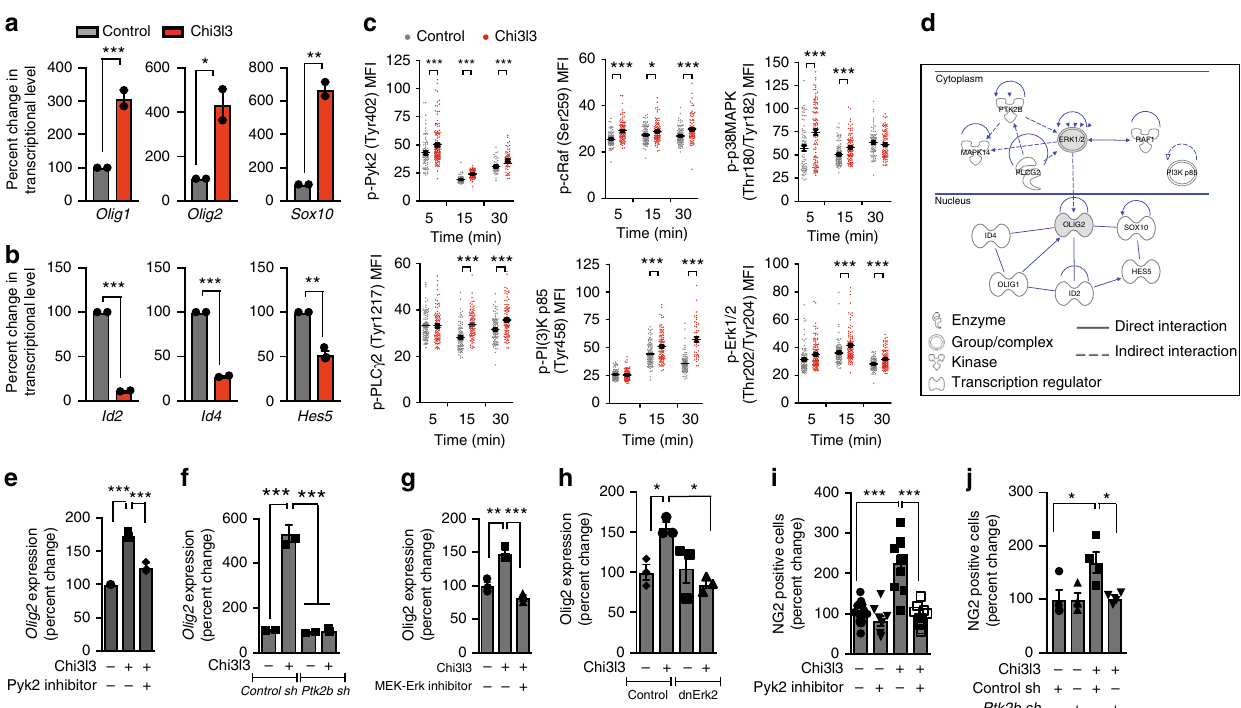
Fig. 3 Chi3l3 induces a pro-oligodendrogenic transcriptional and signaling pro fi le. a , b Gene expression of the pro-oligodendroglial transcription factors Olig1 , Olig2, and Sox10 after 36 h a and negative transcriptional regulators Id2, Id4, and Hes5 after 24 h b in differentiating neural stem cells (NSCs) post exposure to Chi3l3 or PBS (control). c Mean fl uorescence intensity (MFI) quanti fi cation of individual NSCs, activated by Chi3l3 or PBS (control), fi xed at 5, 15, and 30 min and immunostaining for phosphorylation (p)- speci fi c antibodies to various signaling proteins. d Ingenuity pathway analysis showing interconnection between Chi3l3-mediated signaling events ( Ptk2b (Pyk2), MAPK14 (p38MAPK), PLCG2 (PLC γ 2), RAF1 (c-Raf), ERK1/2, PI3K p85 and transcriptional events ( Olig1, Olig2, Sox10, Hes5 , Id2 , Id4 ). e , f Gene expression of Olig2 in differentiating NSCs in the presence of Pyk2 kinase inhibitor PF- 431396 e or NSCs, transfected with control shLVPs or Ptk2b (Pyk2) shLVPs f after 36 h of exposure to Chi3l3 or PBS. g , h Gene expression of Olig2 in differentiating NSCs in presence of MEK-Erk inhibitor U0126 g or NSCs, transfected with LVPs containing GFP (control) or dnErk2-GFP h after 36 h of exposure to Chi3l3 or PBS. Values were normalized to housekeeping genes and expressed as percent change to PBS-treated control NSCs. i Quanti fi cation of NG2 + oligodendrocyte precursor cells, derived from NSCs differentiated for 3 days in the presence ( + ) or absence ( − ) of PF-431396 and Chi3l3 ( + ) or PBS ( − ). j Quanti fi cation of NG2 + oligodendrocyte precursor cells derived from differentiating NSCs, transfected with control shLVPs or Ptk2b shLVPs (Pyk2), and treated with Chi3l3 ( + ) or PBS ( − ). Pyk2 signaling de fi ciency signi fi cantly reduced Chi3l3-induced oligodendrogenesis. Values are